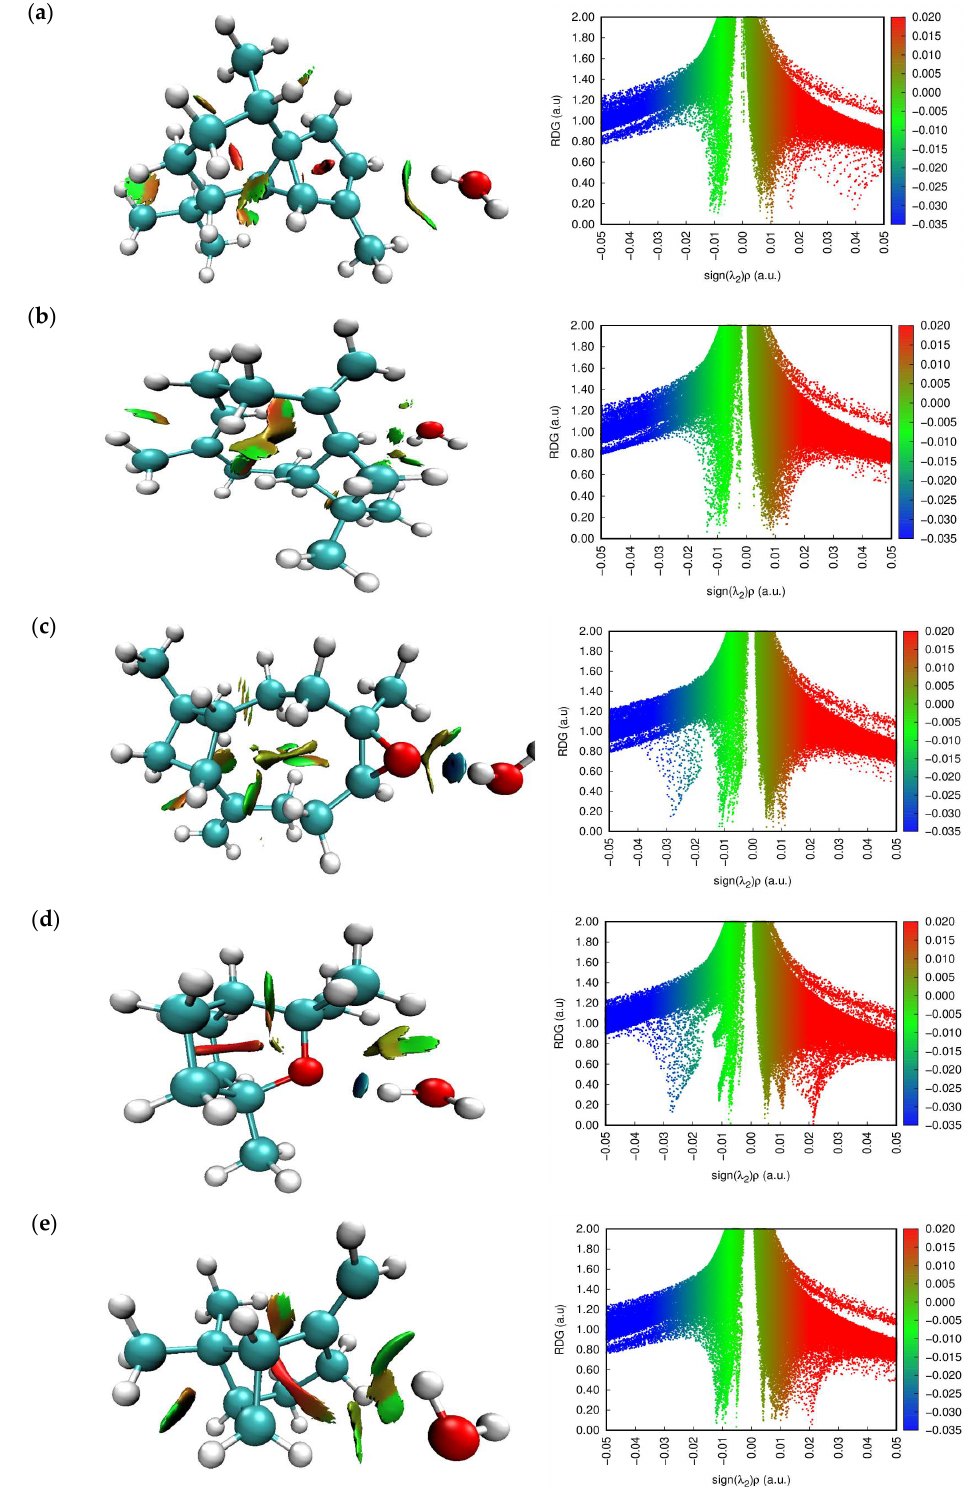
Figure 4. NCI ( left ) and RDG ( right ) plots of the binary mixtures ( α -cubebene–water ( a ), β - caryophyllene–water ( b ), caryophyllene oxide–water ( c ), 1,8-cineole–water ( d ), and β-pinene–water ( e )).